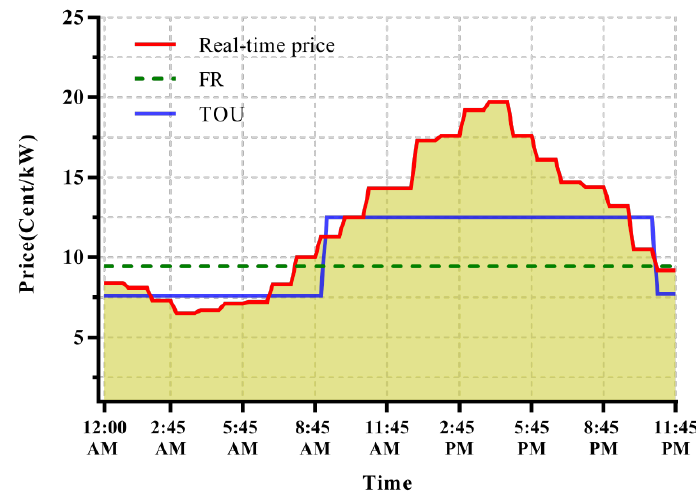
Figure 4. Real-time, flat-rate, and time-of-use price profiles.